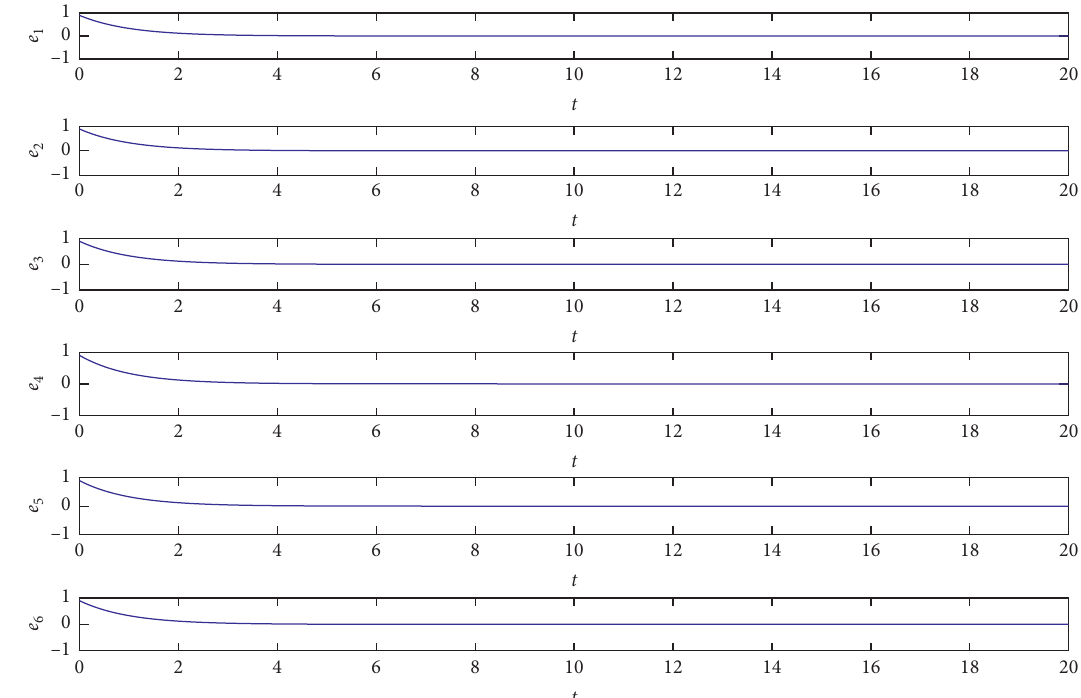
Figure 12: The trajectories of the synchronization errors e